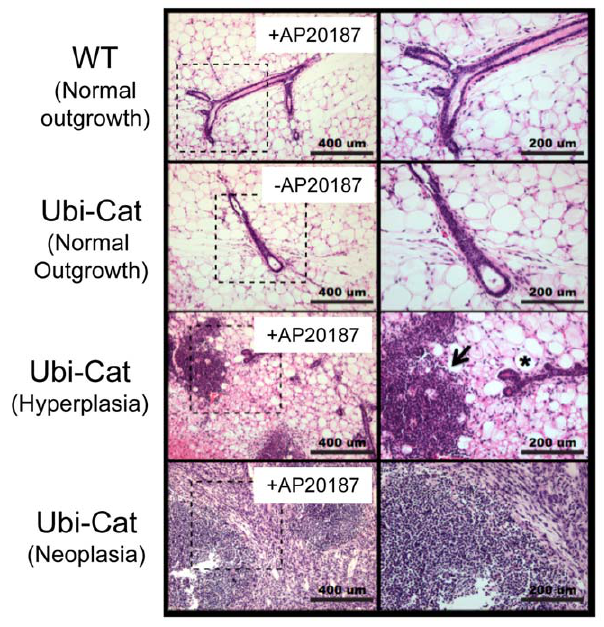
Figure 12. Mammary gland transplant assay using Ubi-Cat- derived mammary cells. Ubi-Cat mammary cells were isolated from 6–8 week adult female Ubi-Cat mice. 5 6 10 3 WT or Ubi-Cat mammary cells were transplanted into virgin adult recipients. WT and